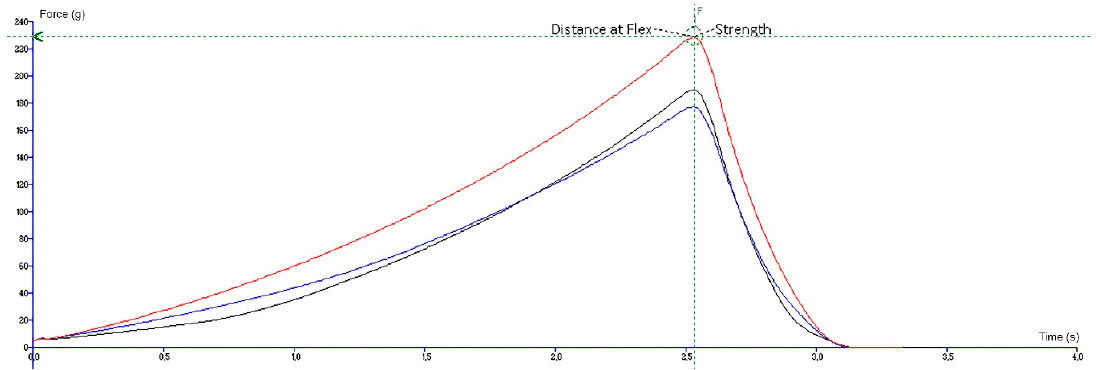
Figure 7. A graphical view of the flexibility test. The lines represent the three replicates of the